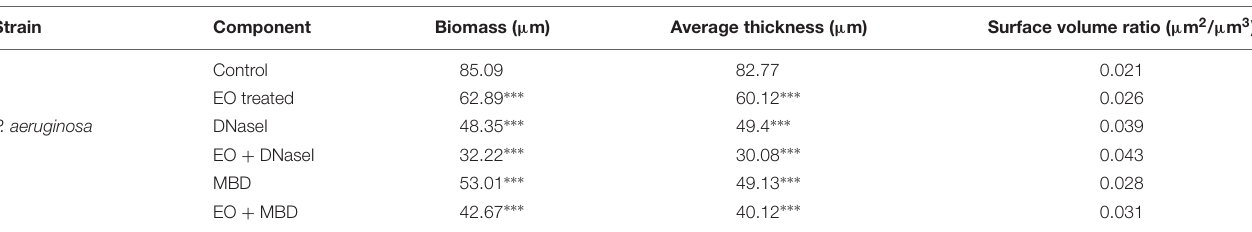
TABLE 2 | COMSTAT analysis of treated and untreated P. aeruginosa